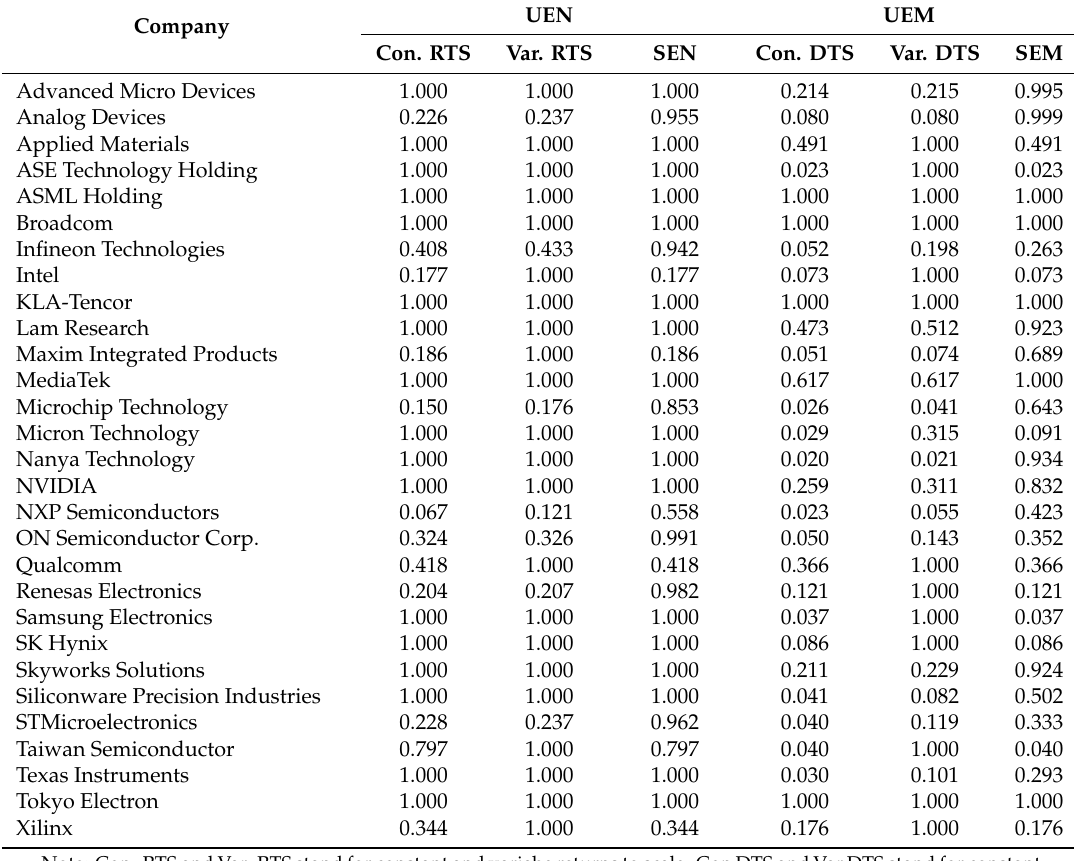
Table 5. Unified e ffi ciency